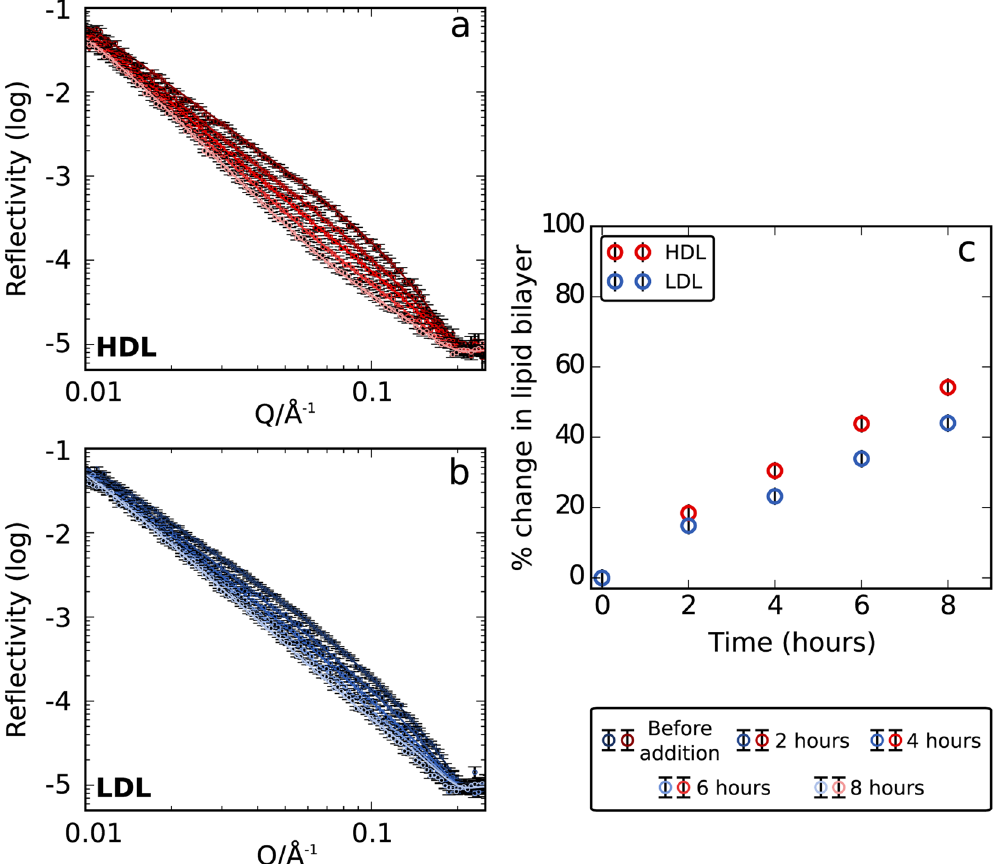
Figure 3. Fitted (lines) experimental (markers) data for a 90:10 mol% DMPC/DMPS d-SLB incubated with ( a ) HDL and ( b ) LDL over 8 hours in hTris. ( c ) Percent of lipid removed from dSLB after incubation with HDL (red markers) or LDL (blue markers) over time calculated from best fit assuming lipid